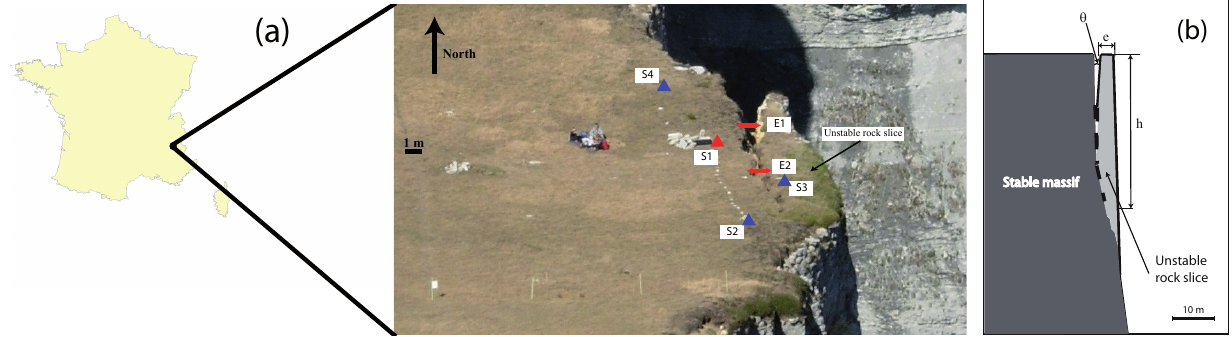
Fig. 1. (a) Geographic location and photographic northward view of the experimental site, showing the stable massif and the unstable rock slice. S1: three-component, S2, S3, S4: vertical geophones; E1, E2: extensometers. S1, E1, E2 operated from 1 August, and S2, S3, S4 operated from 11 October; both stopped 10 November, some days before the collapse of the unstable rock slice. (b) Vertical cross-section of the investigated rock slope, showing the stable massif and the unstable rock slice. Thick dashed lines represent areas where rock bridges are likely to